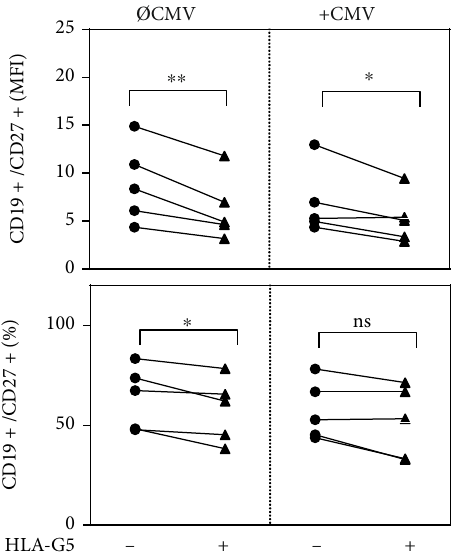
Figure 2: Human leukocyte antigen G5 (HLA-G5) signi fi cantly decreases the surface expression of CD27 in CD19+ splenic cells and reduces the proportion of CD19+CD27+ cells in the total population of CD19+ cells. Di ff erences in CD27 expression in splenic CD19+ cells derived from cytomegalovirus (CMV)- seropositive individuals ( n = 5 ) after overnight cultivation with or without HLA-G5 and CMV antigens. CD27 expression was analyzed by fl ow cytometry and is given as mean fl uorescence intensity index (MFI) and the proportion of CD19+ CD27+ cells in the total population of CD19+ cells (%). Statistical signi fi cance ( P < 0 : 05 ) was determined by two-tailed paired t -test. ∗ P < 0 : 05 , ∗∗ P < 0 : 01 .